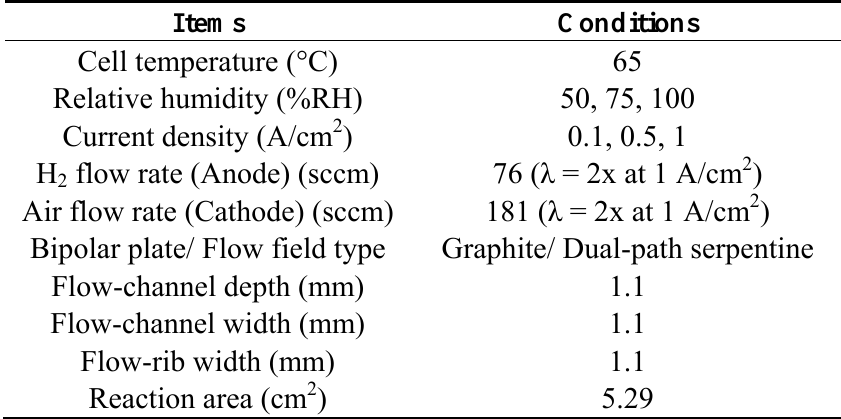
Table 1. Operating conditions and specifications of PEM fuel